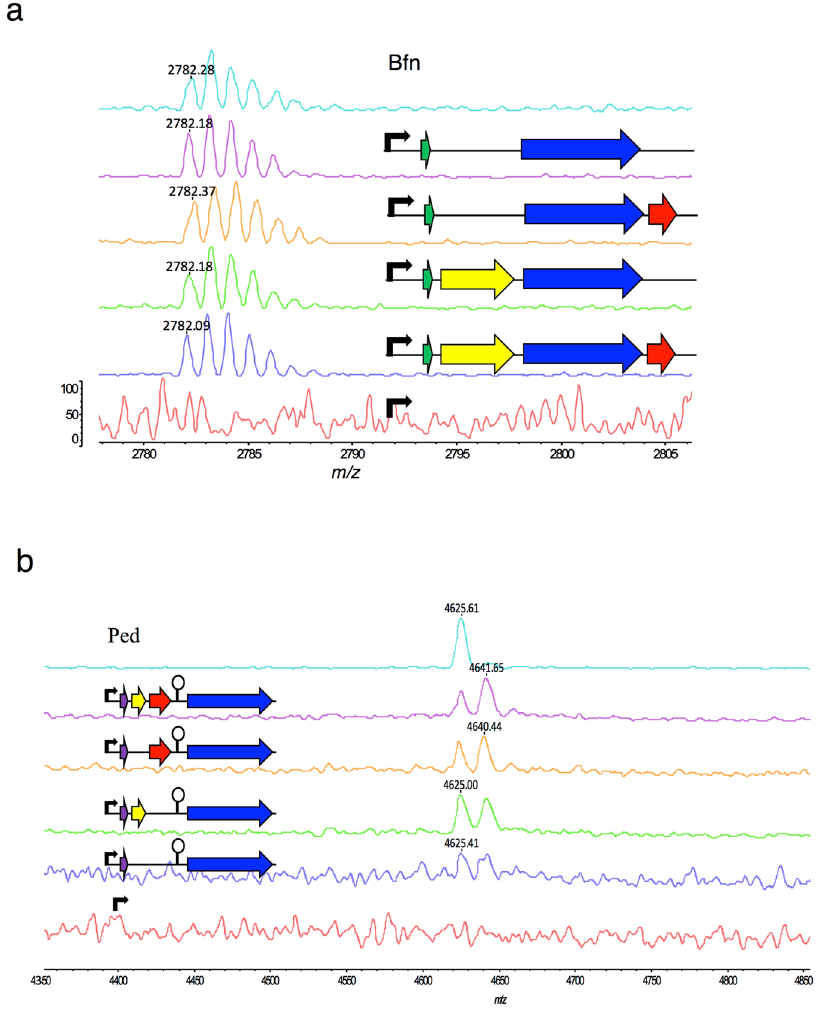
Figure 5. MALDI-TOF mass spectrometry analysis. ( a ) Soluble extracellular fractions from bactofencin A E . coli producers and ( b ) pediocin PA-1 producers after 3 hours of IPTG induction. Samples from the natural producers Lb . salivarius DPC6502 and P . acidilactici LMG2351 are indicated as Bfn and